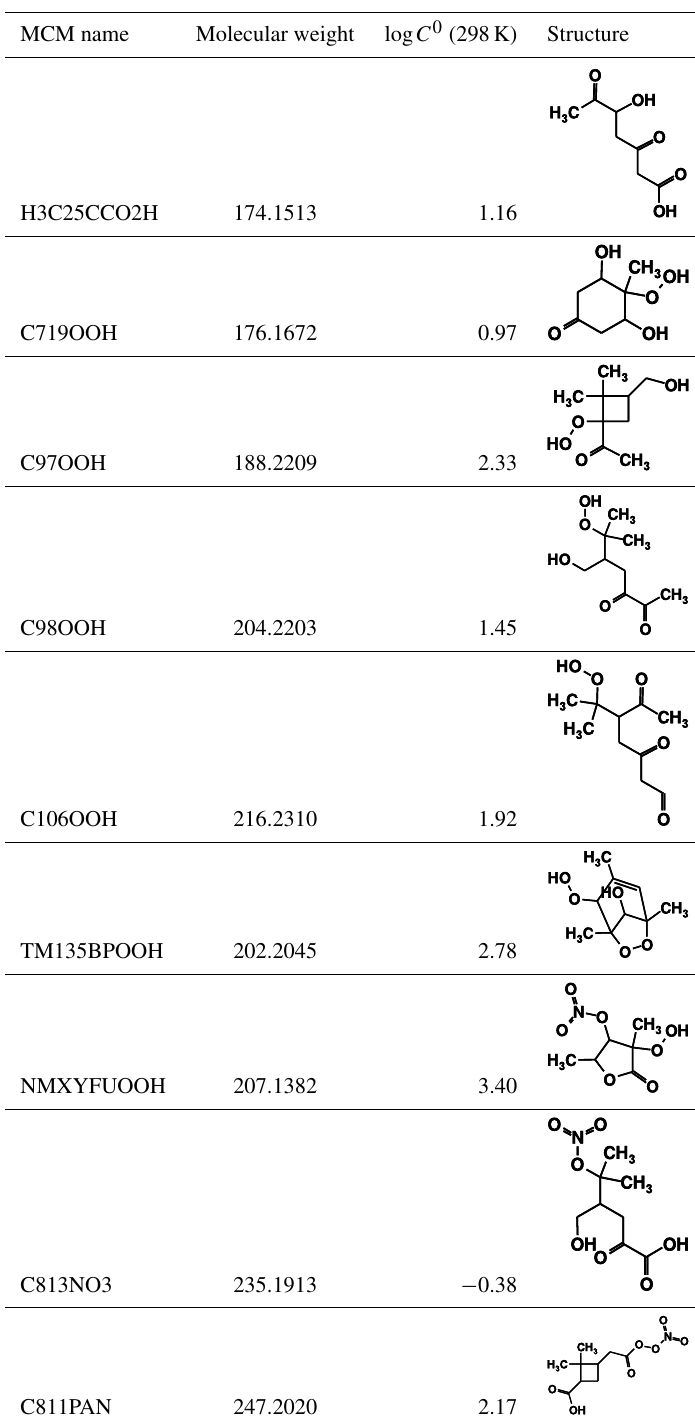
Table 2. Illustration of several polyfunctional molecules discussed in Section